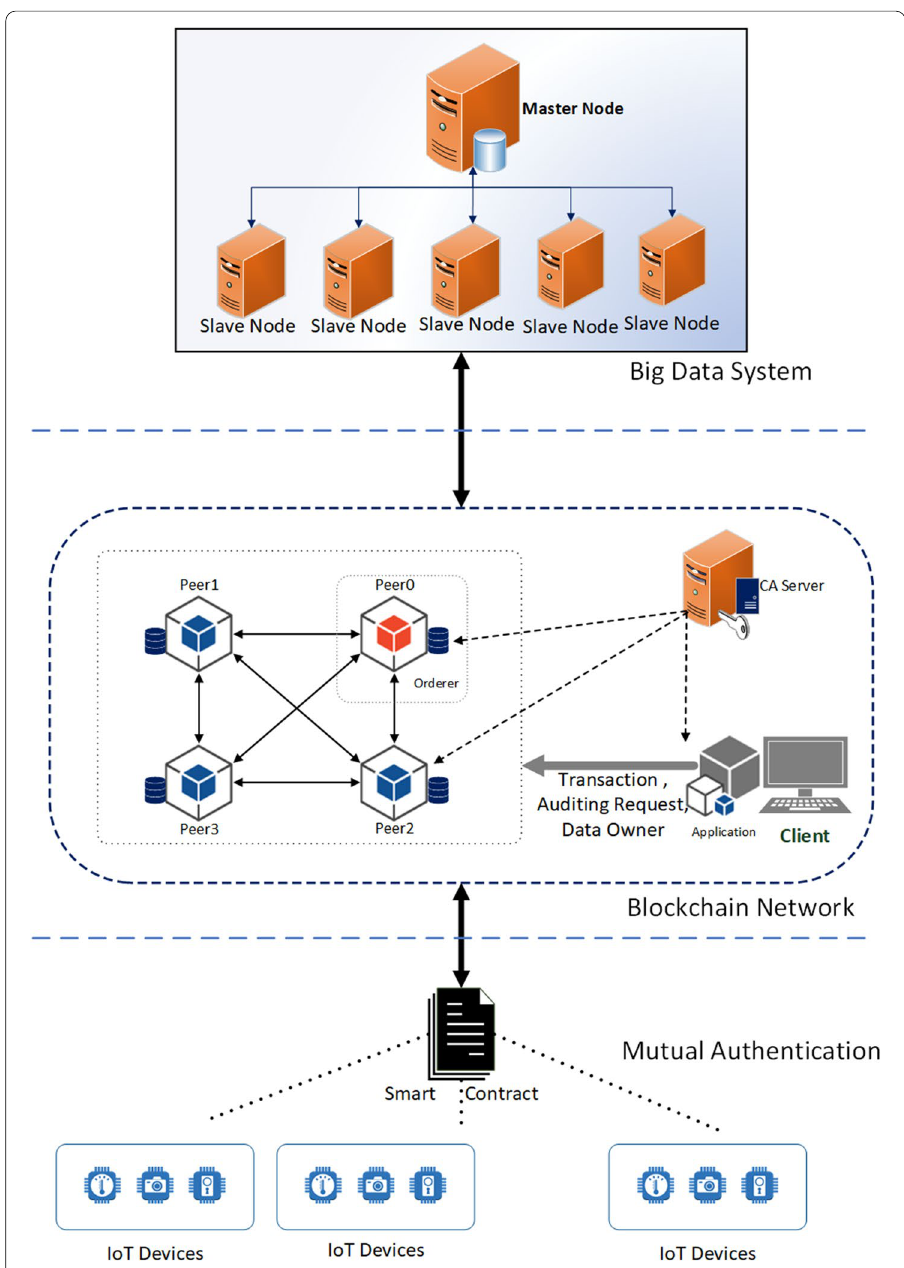
Fig. 3 Proposed blockchain-enabled secure big data provenance scheme for large-scale